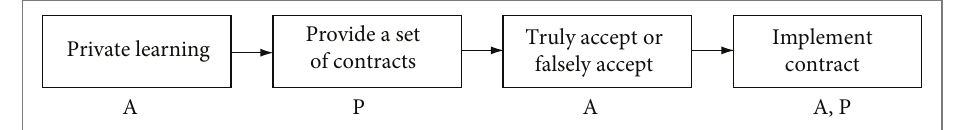
Fig. 2. Contract schedule between the central government and the local